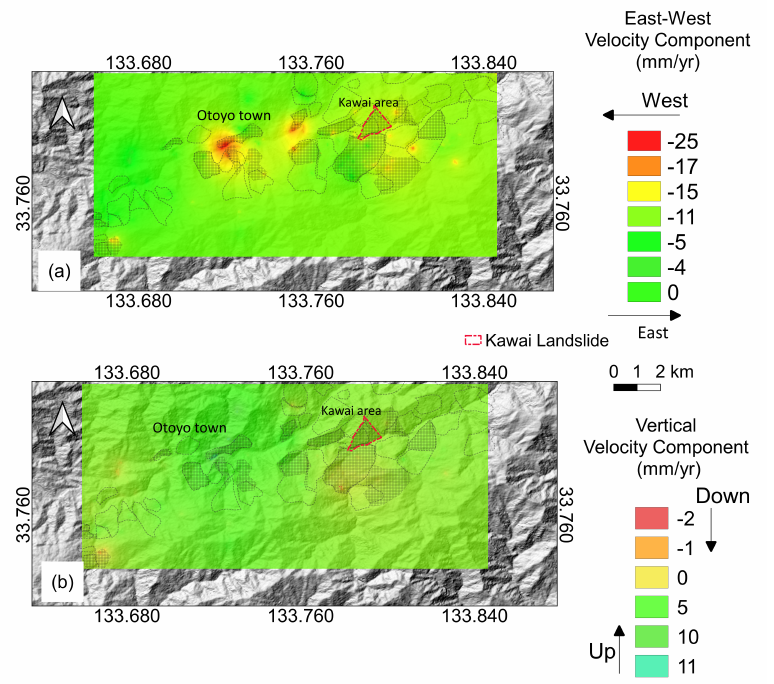
Figure 6. Horizontal and vertical components after inverted distance-weighted interpolation and decomposition of both the ascending and descending LoS velocity values. Horizontal component: ( a ) active landslide locations moving towards the west along the slope direction; vertical component: ( b ) minor vertical movement in the downward